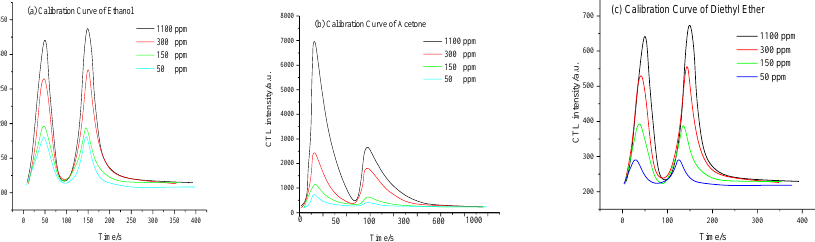
Figure 10. CTL response profiles of ethanol with ( a ) acetone and ( b ) diethyl ether and ( c ) signal values (flow rate: 310 mL/min, temperature: 220 °C, wavelength: 590 nm).